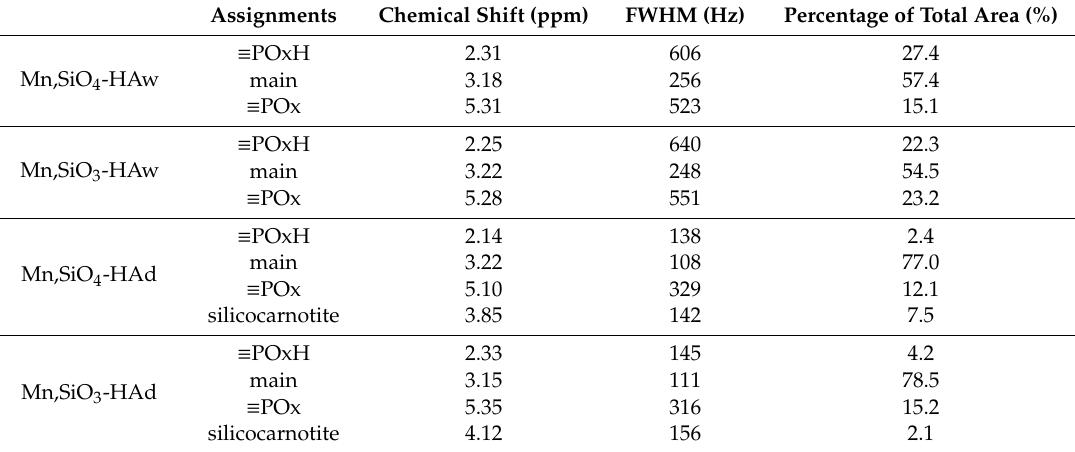
Figure 5. Representative deconvolution of the 31 P BD NMR spectra: ( A ) Mn,SiO 4 -Haw and ( B ) Mn,SiO 4 -HAd. Table 2. NMR deconvolution results for the 31 P BD NMR experiments (FWHM—full width at half